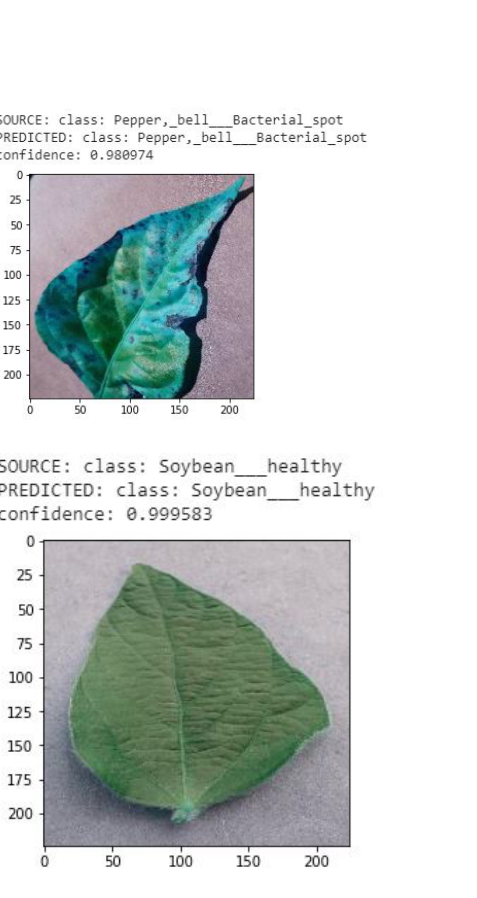
Figure 8. Performance accuracy with different dropout values.